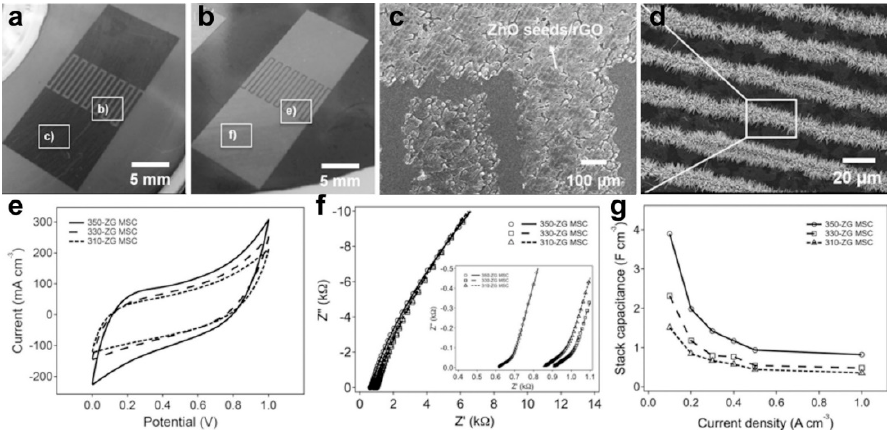
Figure 2. ZnO/rGO composites based on-chip MSC. ( a , b ) Photograph of the interdigital electrode with ZnO seeds/rGO and ZnO nanorods/rGO materials, respectively; ( c ) SEM image of the ZnO/rGO finger electrode; ( d ) High-solution SEM image of the ZnO/rGO electrodes; ( e ) C V curves of the ZnO/rGO based on-chip MSC; ( f ) Nyquist plots; ( g ) Specific capacitance of the fabricated MSC. The figure has been reproduced with permission from Springer Nature [56].